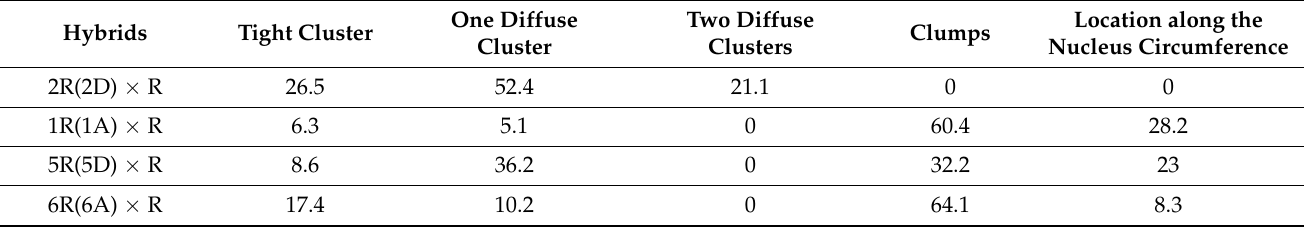
Figure 2. Telomere and centromere distribution in 2R(2D) × R hybrids. ( a , b ) Leptotene. ( c , d ) Early zygotene. ( e – h ) Zygotene. ( i ) Meiocytes at late zygotene (1, 2) and pachytene (3). Telomere bouquet is preserved (1) and resolved (2). Dispersed point telomeres and elongated centromeres are scattered within the nucleus (3). ( ai – ii ) the same as ( a – i ), DAPI counterstaining. Telomeres are stained red , centromeres, green . Scale bar = 10 μ m.×. Table 1. Percent of meiocytes with different types of telomere associations at zygotene in wheat–rye F 1 hybrids (FISH).